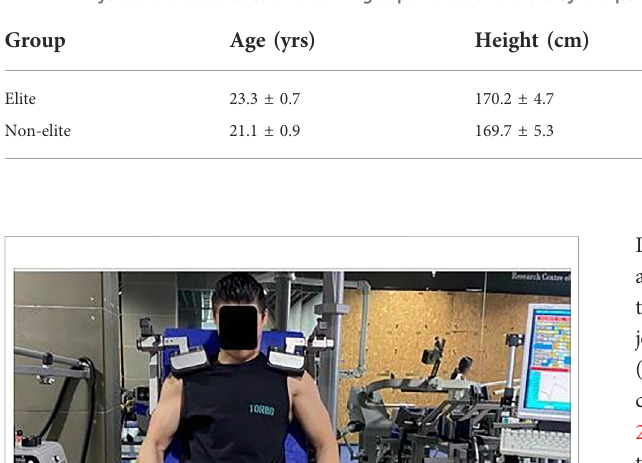
TABLE 1 Physical characteristics and training experience of boxers by the performance group.